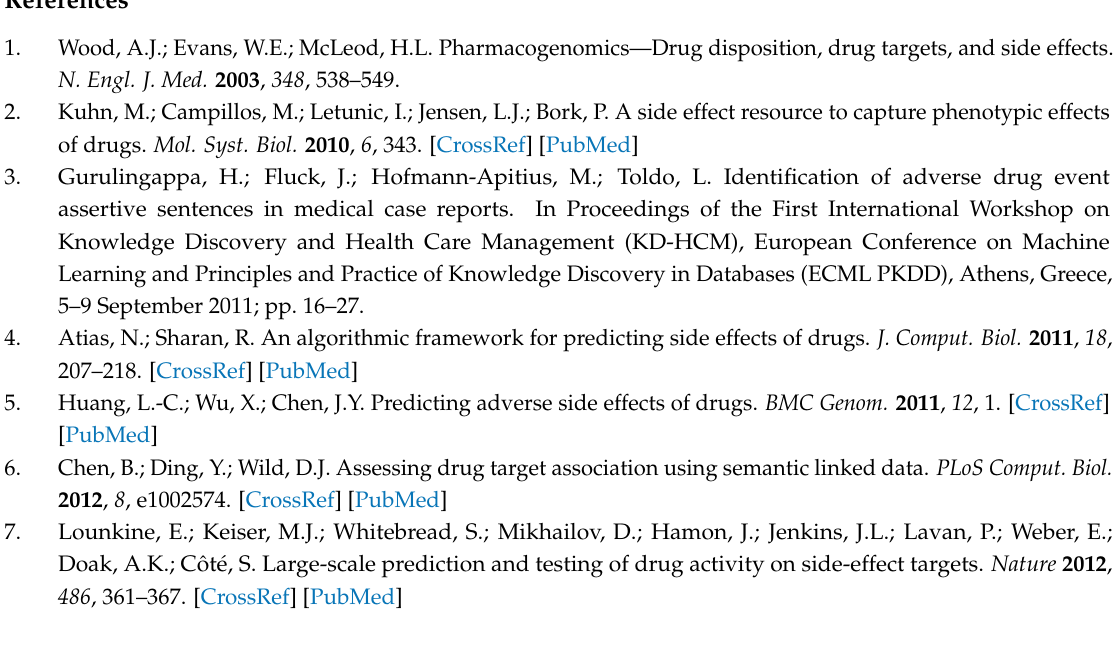
Figure S1: Path1 (Type 2) and Path 2 (Type 3), Figure S2: Path 15 (Type 2), Table S1: Ranking function result, File S1: Further literature